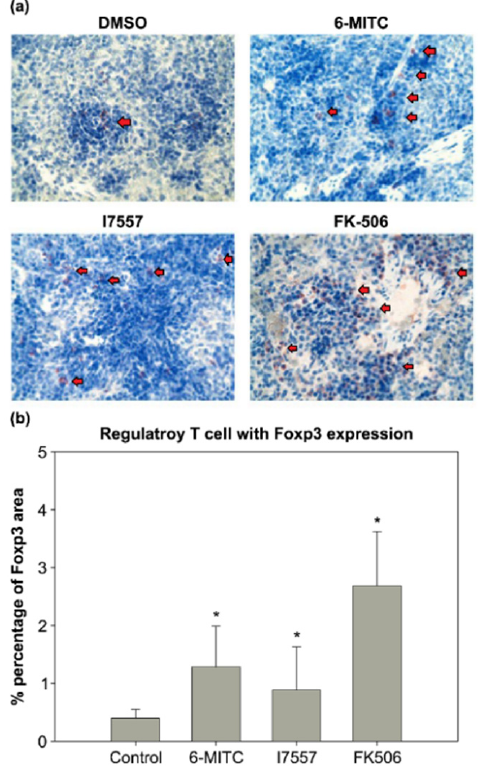
Figure 8. Comparison of spleen tissue histology. The spleen tissue sections were stained for Foxp3 immunohistochemically after treatment with 5 mg/kg 6-MITC, I7557 5, and 3 mg/kg FK-506 com- pared with the controls. The I7557- and 6-MITC-treated groups exhibited higher regulatory T-cell expression compared with the control group. Arrowheads indicate Foxp3+ cells. ( a , b ) In 6-MITC and I7557-treated groups, more Foxp3-expressing Treg cells were accumulated in the spleen * p < 0.05 compared with the control group (unpaired Student t -test). Magnification 400 × .